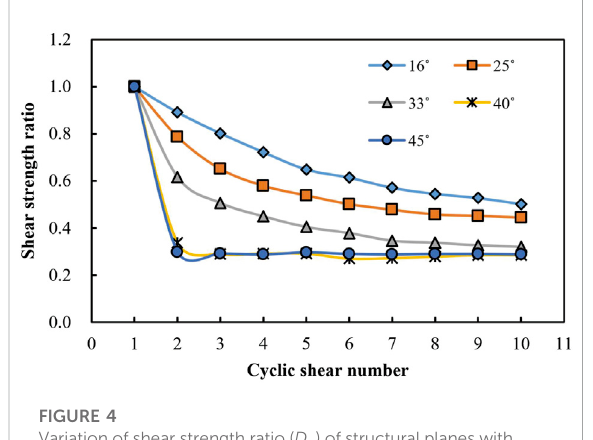
FIGURE 4 Variation of shear strength ratio ( D n ) of structural planes with fi ve kinds of initial undulant angles with cyclic shear number under σ n =0.8 MPa (Liu et al.,